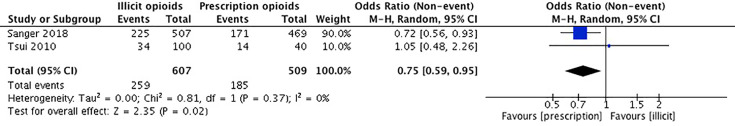
Forest Plot for Alcohol Use.